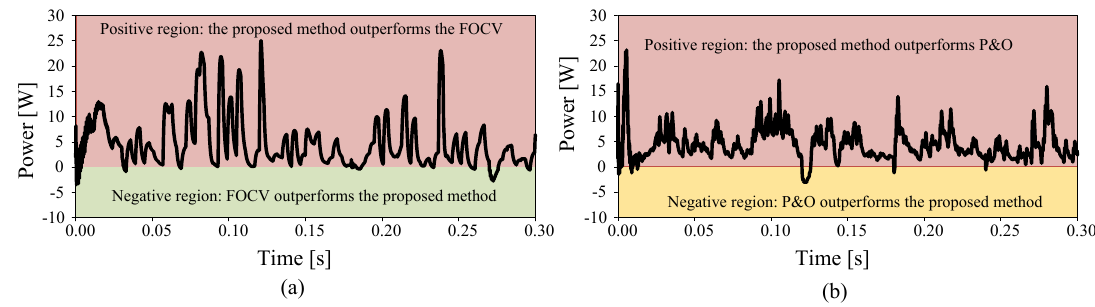
Figure 16. The output waveform of the PV panel for Case 2 using various tracking algorithms: ( a ) The performance over a long time period. ( b ) Zoomed area.